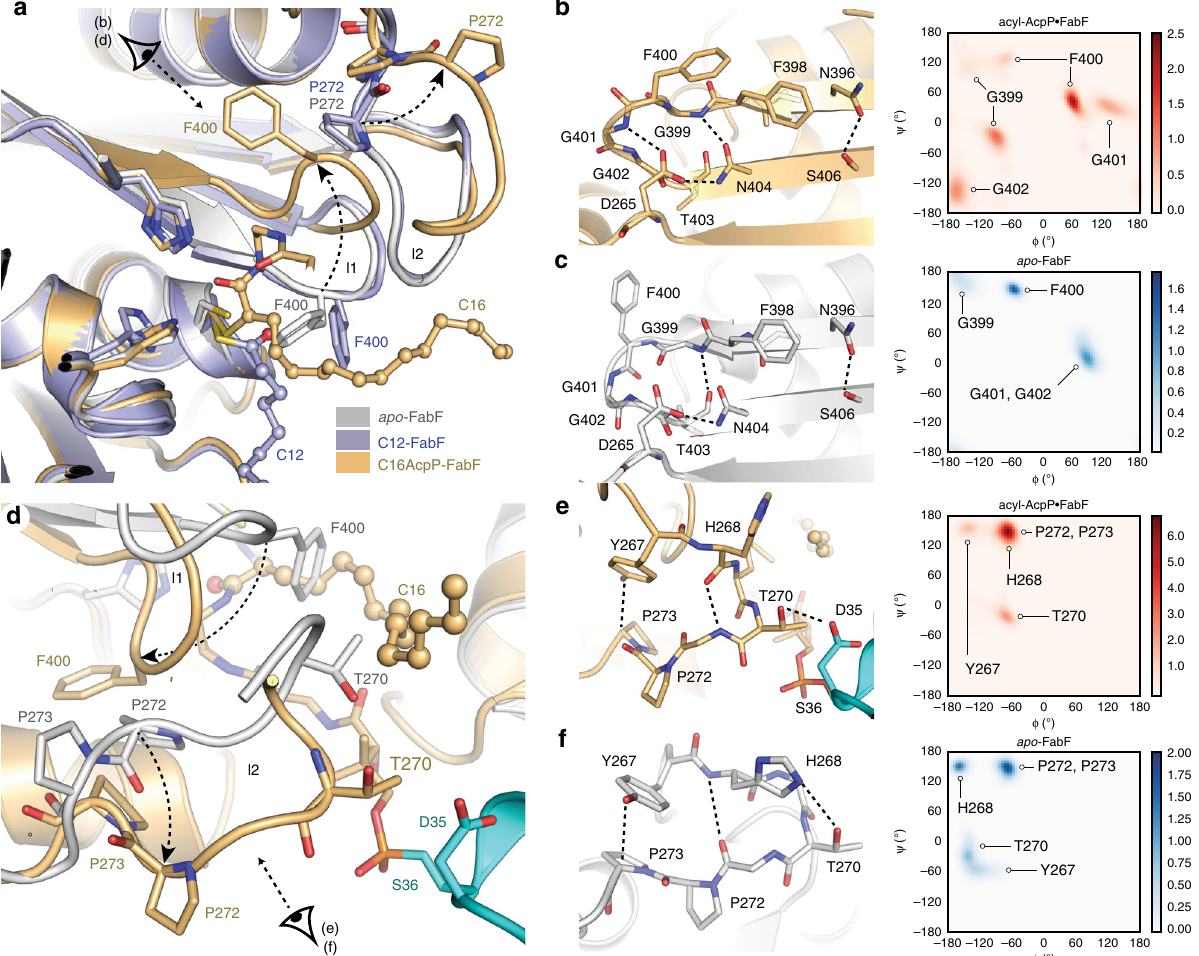
Fig. 5 Conformational changes in FabF active site loops. a Comparison of F400, loop 1, and loop 2 conformations of apo -FabF (light grey, PDB: 2GFW 43 ), dodecanoyl-FabF (light purple, PDB: 2GFY 43 ), and C16AcpP – FabF (light orange, PDB: 6OKG). b Interactions that stabilize the open-conformation of the β - turn motif of loop 1 in C16AcpP – FabF and associated Ramachandran analysis of the conserved GFGG sequence within loop 1 from 1.5 μ s of 10:0-AcpP·FabF, 12:0-AcpP·FabF, 16:0-AcpP·FabF (total of 4.5 μ s) molecular dynamics (MD) simulation data. c Interactions that stabilize the closed-conformation of the β - turn motif of loop 1 in apo -FabF (light grey) and associated Ramachandran analysis of the conserved GFGG sequence within loop 1 from 1.5 μ s of MD simulation data of apo -FabF. d Loop 2 overlay of apo -FabF (light grey, PDB: 2GFW) and C16AcpP – FabF (light orange) with the crosslinked AcpP colored cyan. e Interactions that stabilize the β -turn open conformation of loop 2 in C16AcpP – FabF (light orange) and associated Ramachandran analysis of key loop 2 residues of FabF monomers of acyl-AcpP·FabF complexes (gate-open conformation) from 1.5 μ s of 10:0-AcpP·FabF, 12:0-AcpP·FabF, 16:0-AcpP·FabF (total of 4.5 μ s) MD simulation data. f Interactions that stabilize the loop 2 closed conformation in apo -FabF (white) and associated Ramachandran analysis of key loop 2 residues of FabF of apo -FabF (gate-closed conformation) from 1.5 μ s of MD simulation data of apo -FabF. a – f Residues are shown as sticks and colored according to element. Hydrogen-bond interactions are highlighted using dotted lines. b , c , e , f Simulated backbone φ and ψ dihedrals were binned using widths of 5°. Color bars indicates density of data points within each 2D